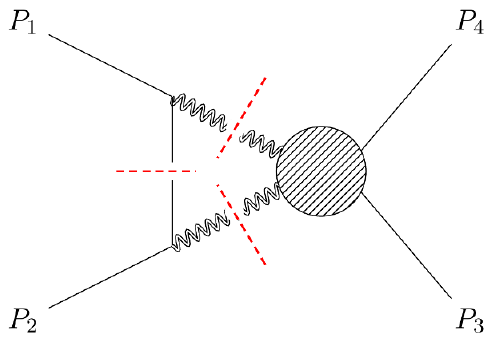
JHEP12(2019)019